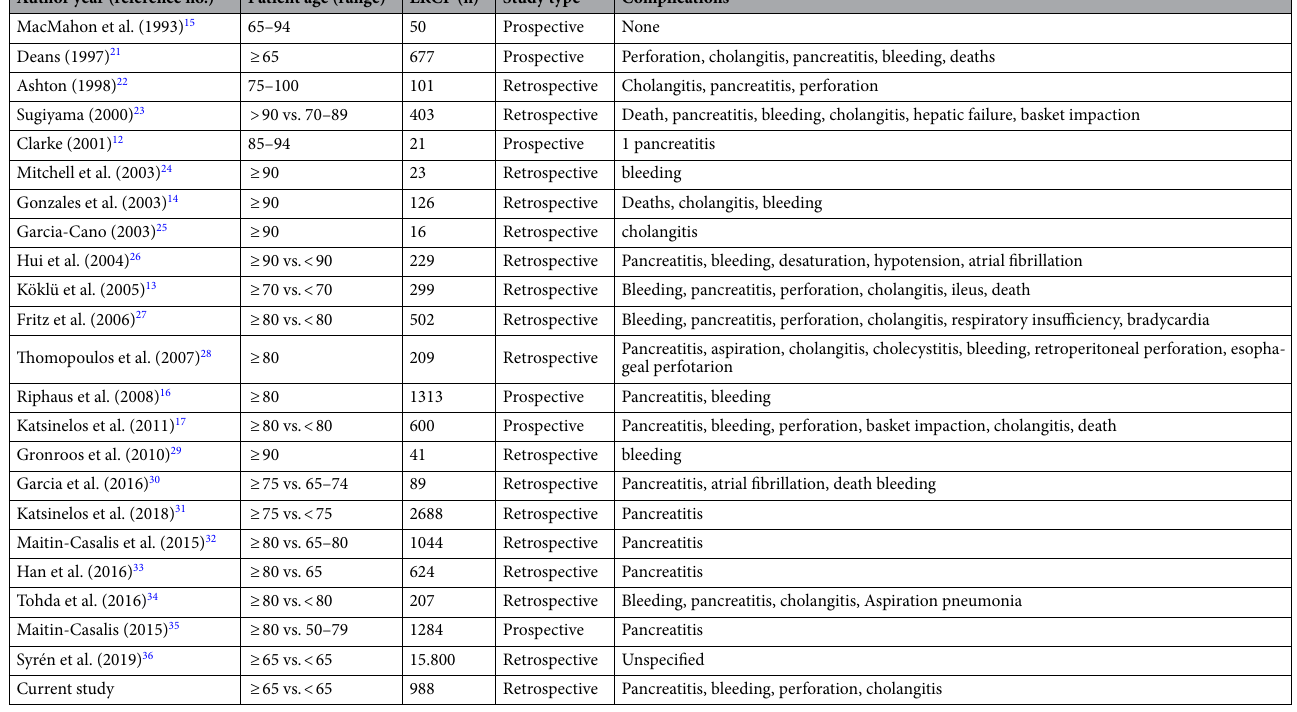
Table 3. Reported series about ERCP in